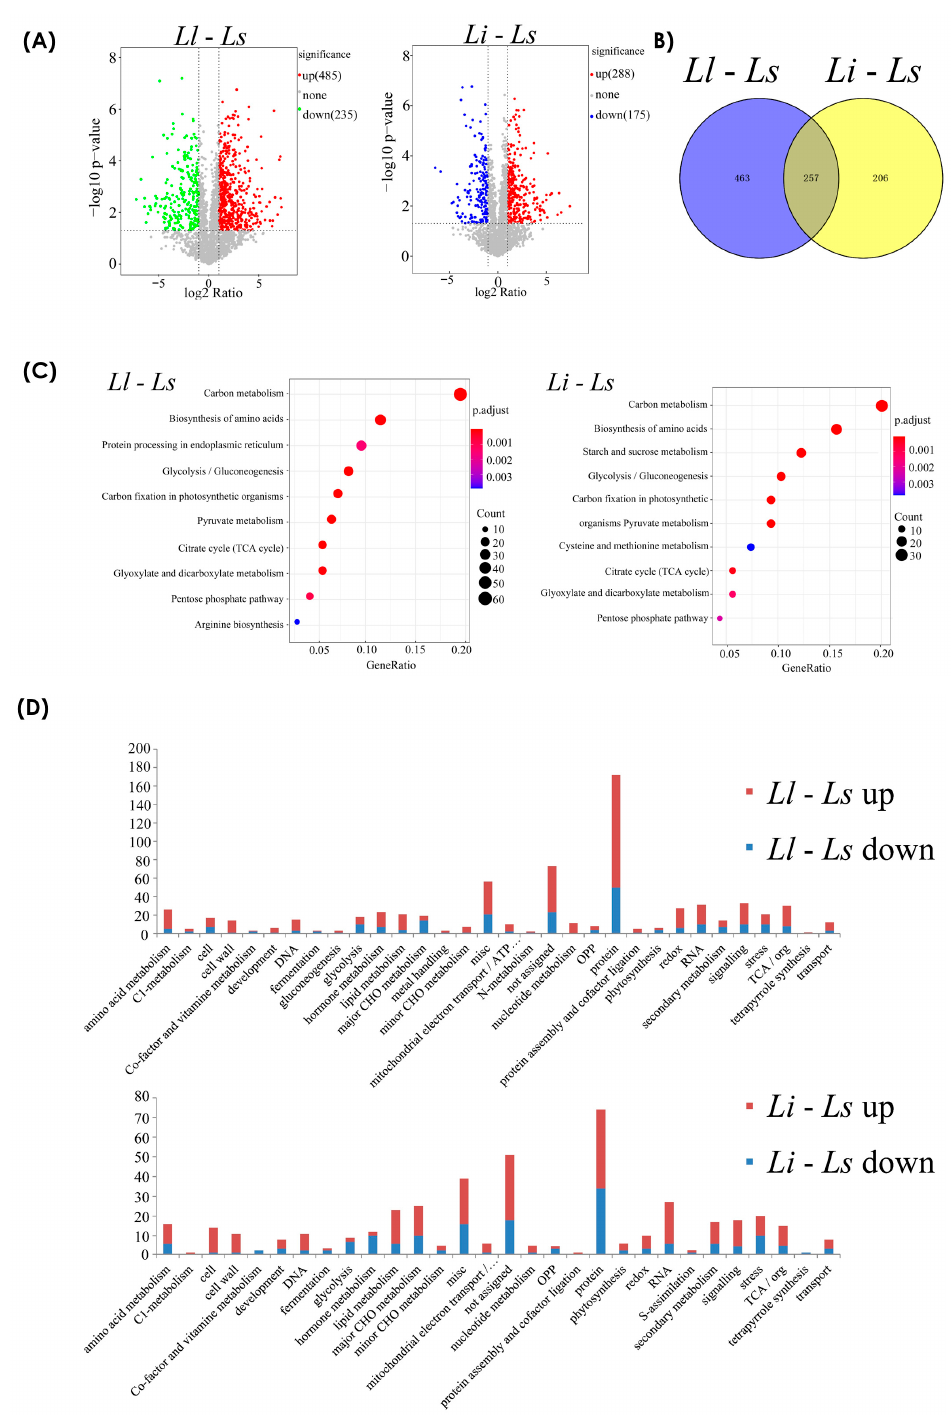
Figure 2. The overview and functional classification by KEGG and MAPMAN BIN.of DEPs. ( A ) The volcano picture shows the distribution of differentially expressed proteins with different fold changes. ( B ) Venn diagram shows the number of differential proteins compared between the two groups. ( C ) KEGG pathway classification was performed on the differential proteins of the 2 groups and enriched in the top 10 pathways. Amino acid biosynthesis, starch, and sucrose metabolic pathways are significantly activated. ( D ) MAPMAN BIN categorization of DEPs; blue and red represent down-regulated and up-regulated proteins,